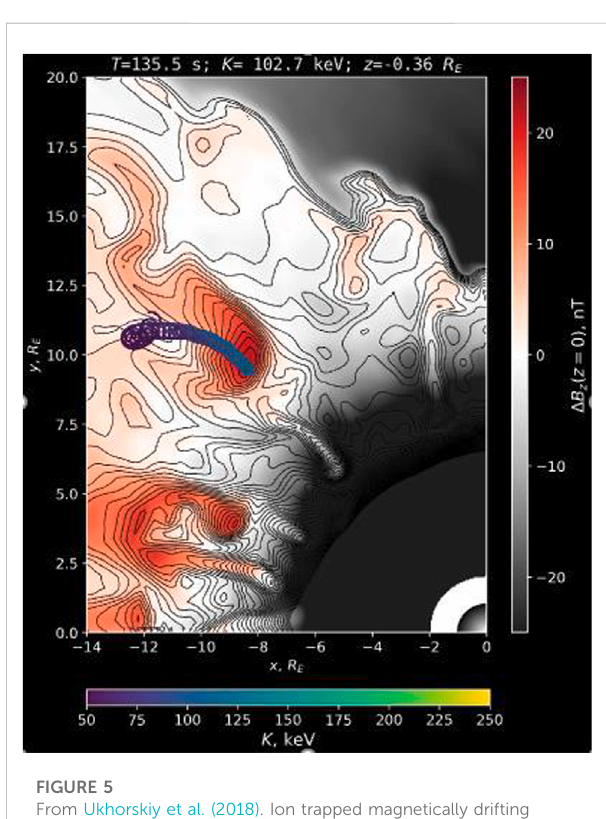
FIGURE 5 From Ukhorskiy et al. (2018). Ion trapped magnetically drifting about the local peak in Bz from the mesoscale, earthwardtraveling